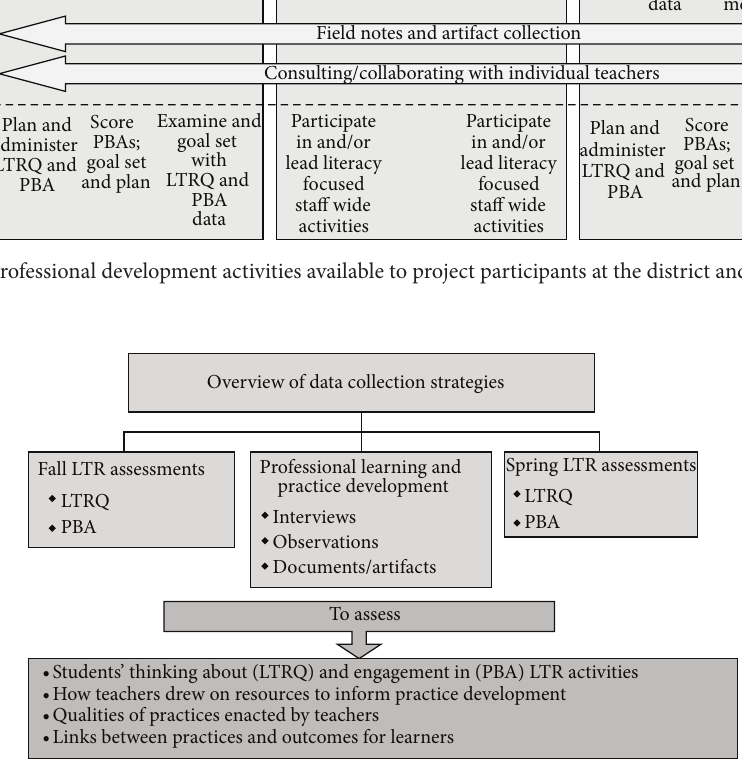
F 4: Overview of data collection